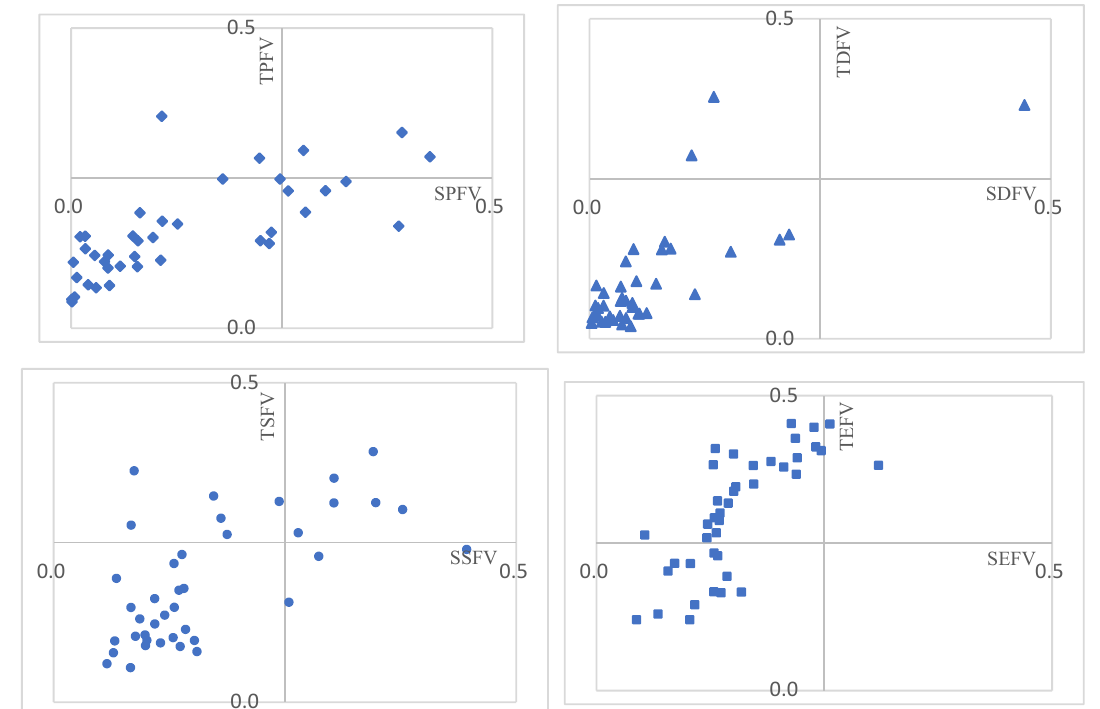
Figure 7. Quadrant diagram of LUFs.